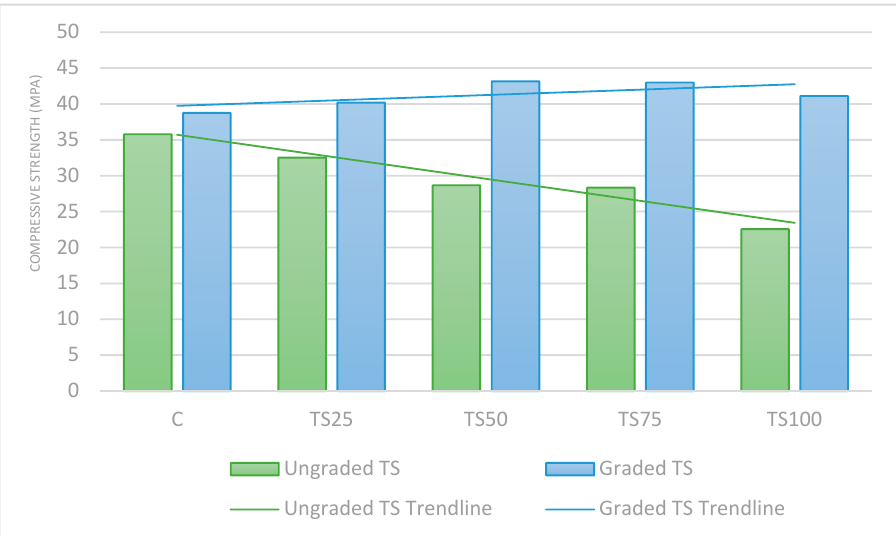
Figure 13. 28-day compressive strength of ungraded and graded TS mortars at a w / c of 0.55.